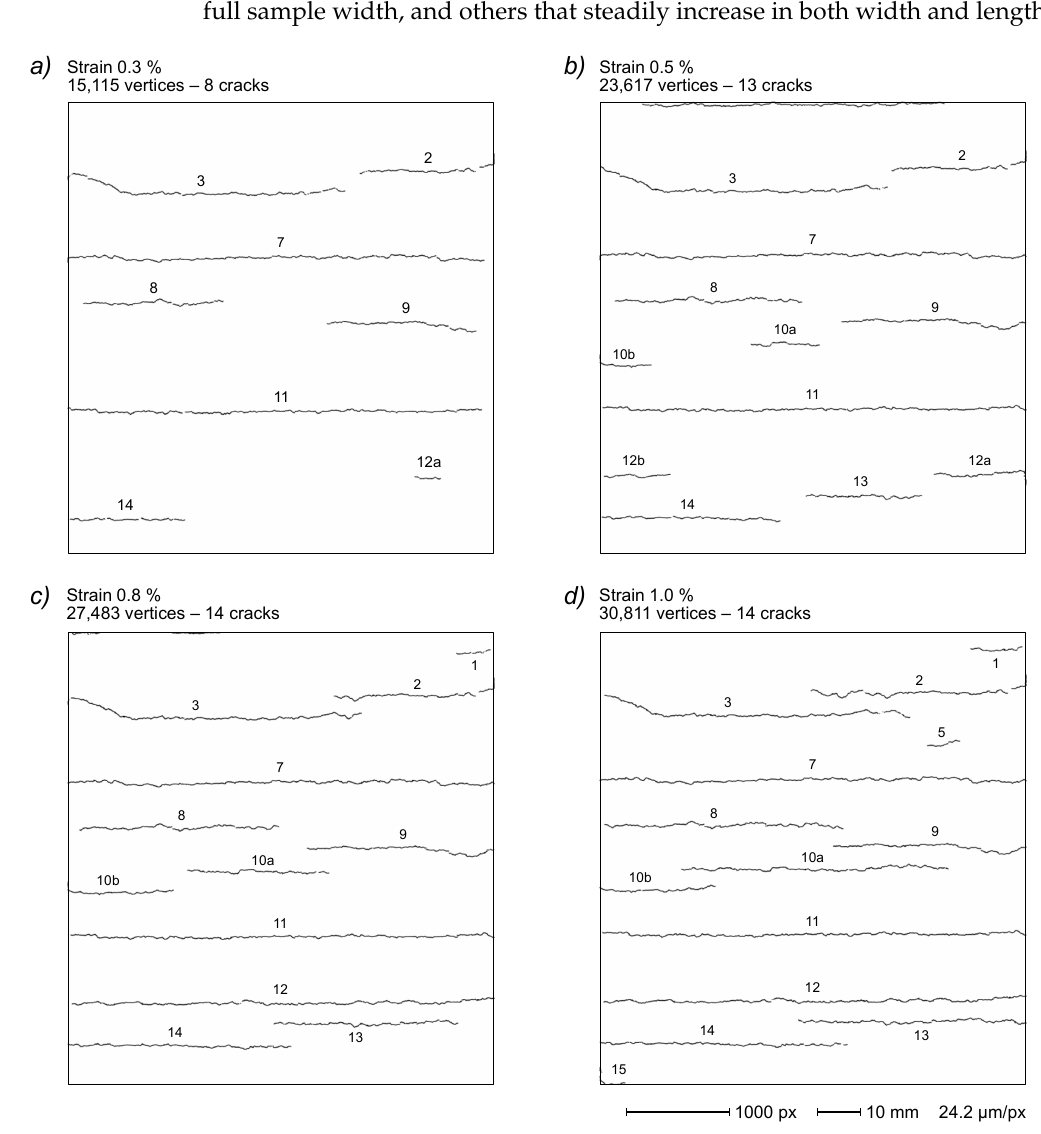
1000 px 10 mm 24.2 Figure 15. Crack patterns (final EGs) of the sample depicted in Figure 4a at different strain levels (from 0.3% to 1.0%). Cracks labelled as the corresponding cracks at 1.5% strain (Figure 4f). The previously described enhancements in crack pattern refinement and analysis The analysis of the crack evolution results in a specific genealogy tree for each crack made possible by the EG-based description allow to increase the reliability of such analyses recorded in the final step image. The computed trees (Figure 16) show two crack coales- with interesting potential in the development of systems for automated structural health cence events at 0.8% and 1.5% strain (for crack 12 and 10, respectively). monitoring. Moreover, the availability of crack EGs allows to perform an effective image- to-image crack correlation using polished path data, avoiding possible issues related to noise and image segmentation